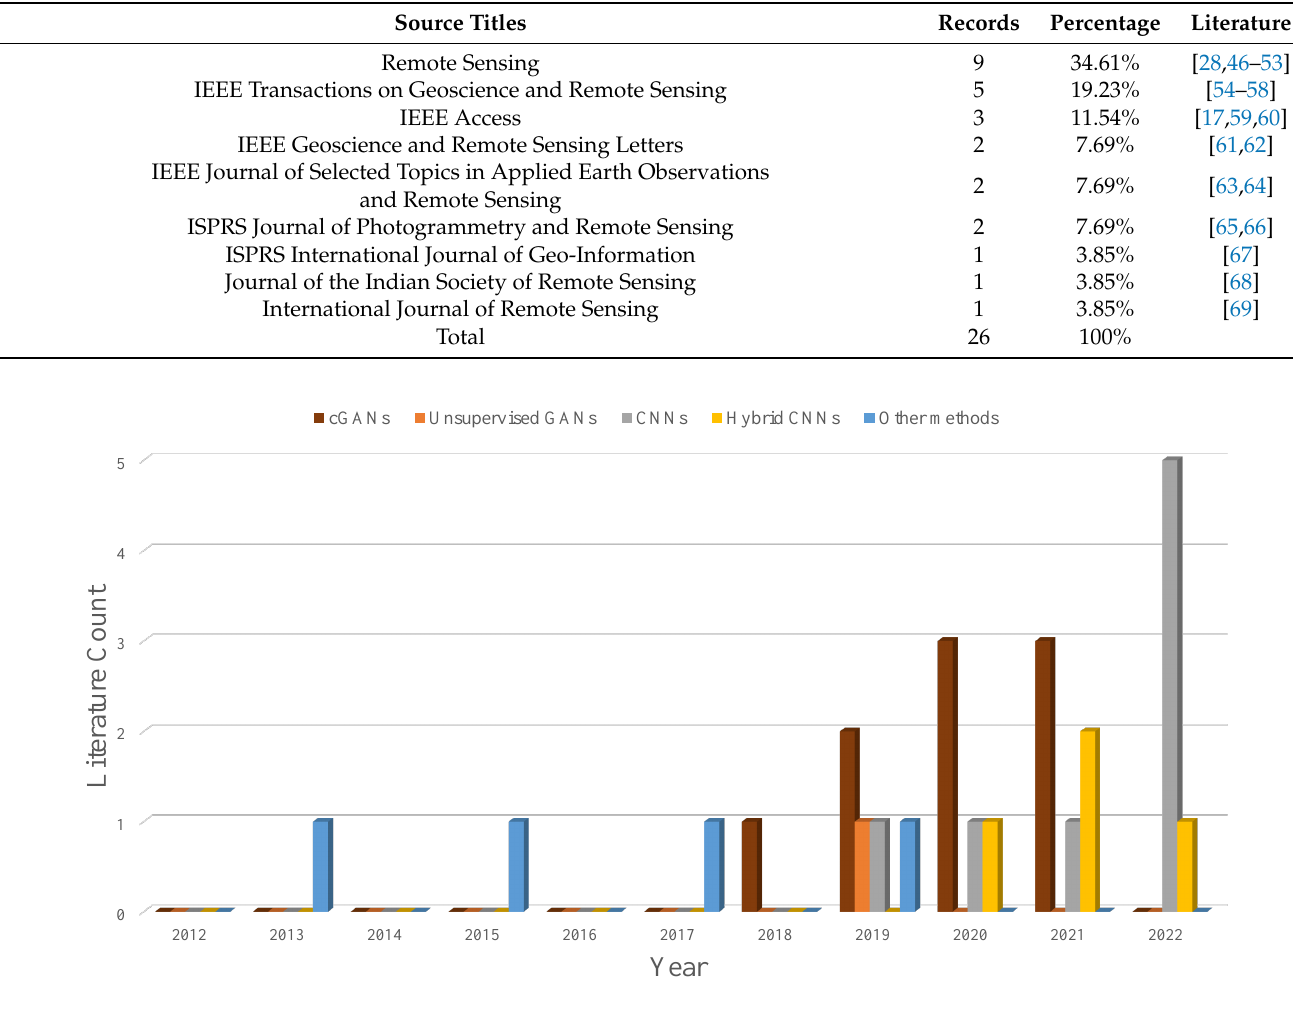
Figure 2. Yearly journal literature counts of different methods for removing clouds from optical data using